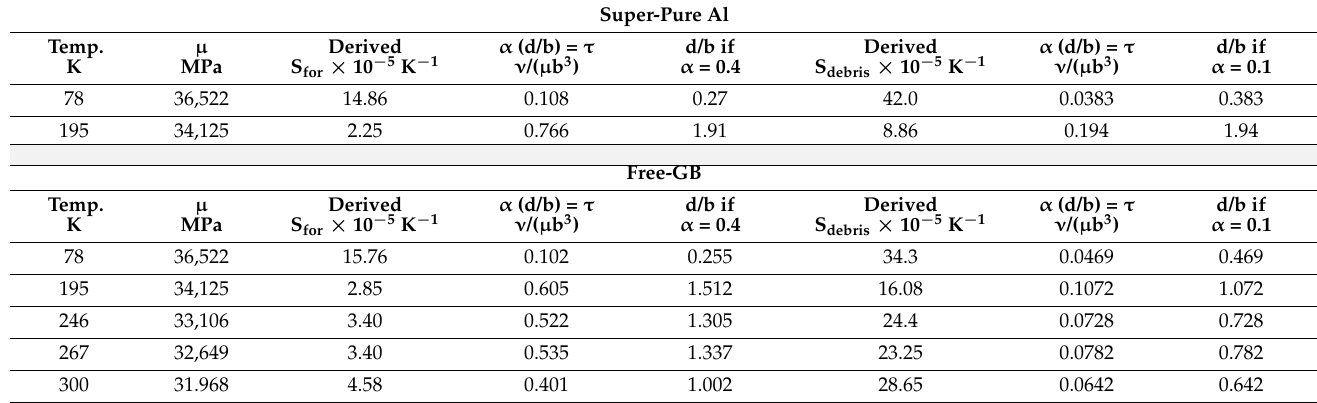
Table 4. Derived d/b from α (d/b) using α for = 0.4 and α debris = 0.1. Super-Pure